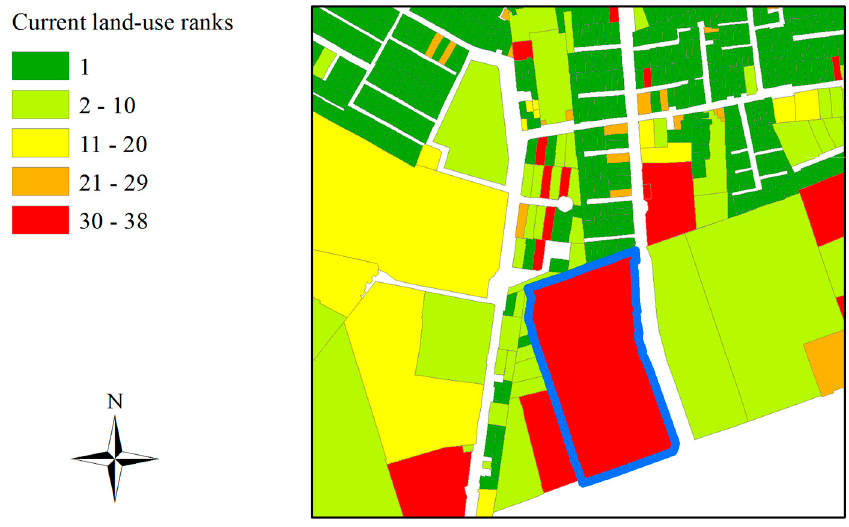
Figure 8. A selected urban parcel. Table 7. A section of the decision matrix of an urban